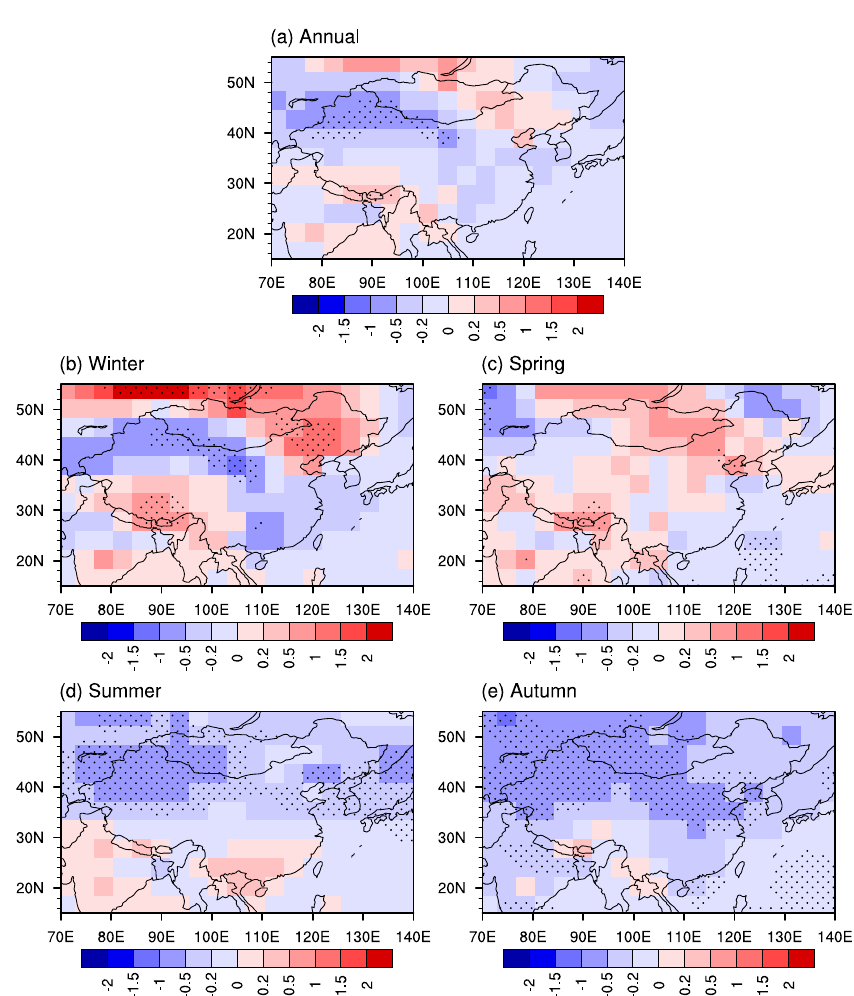
Fig. 9. Annual and seasonal temperature changes (units: K) between (AOV(6ka)–AOV(0ka)) and (AO(6ka)–AO(0ka)) experiments. The areas exceeding 90% confidence level are